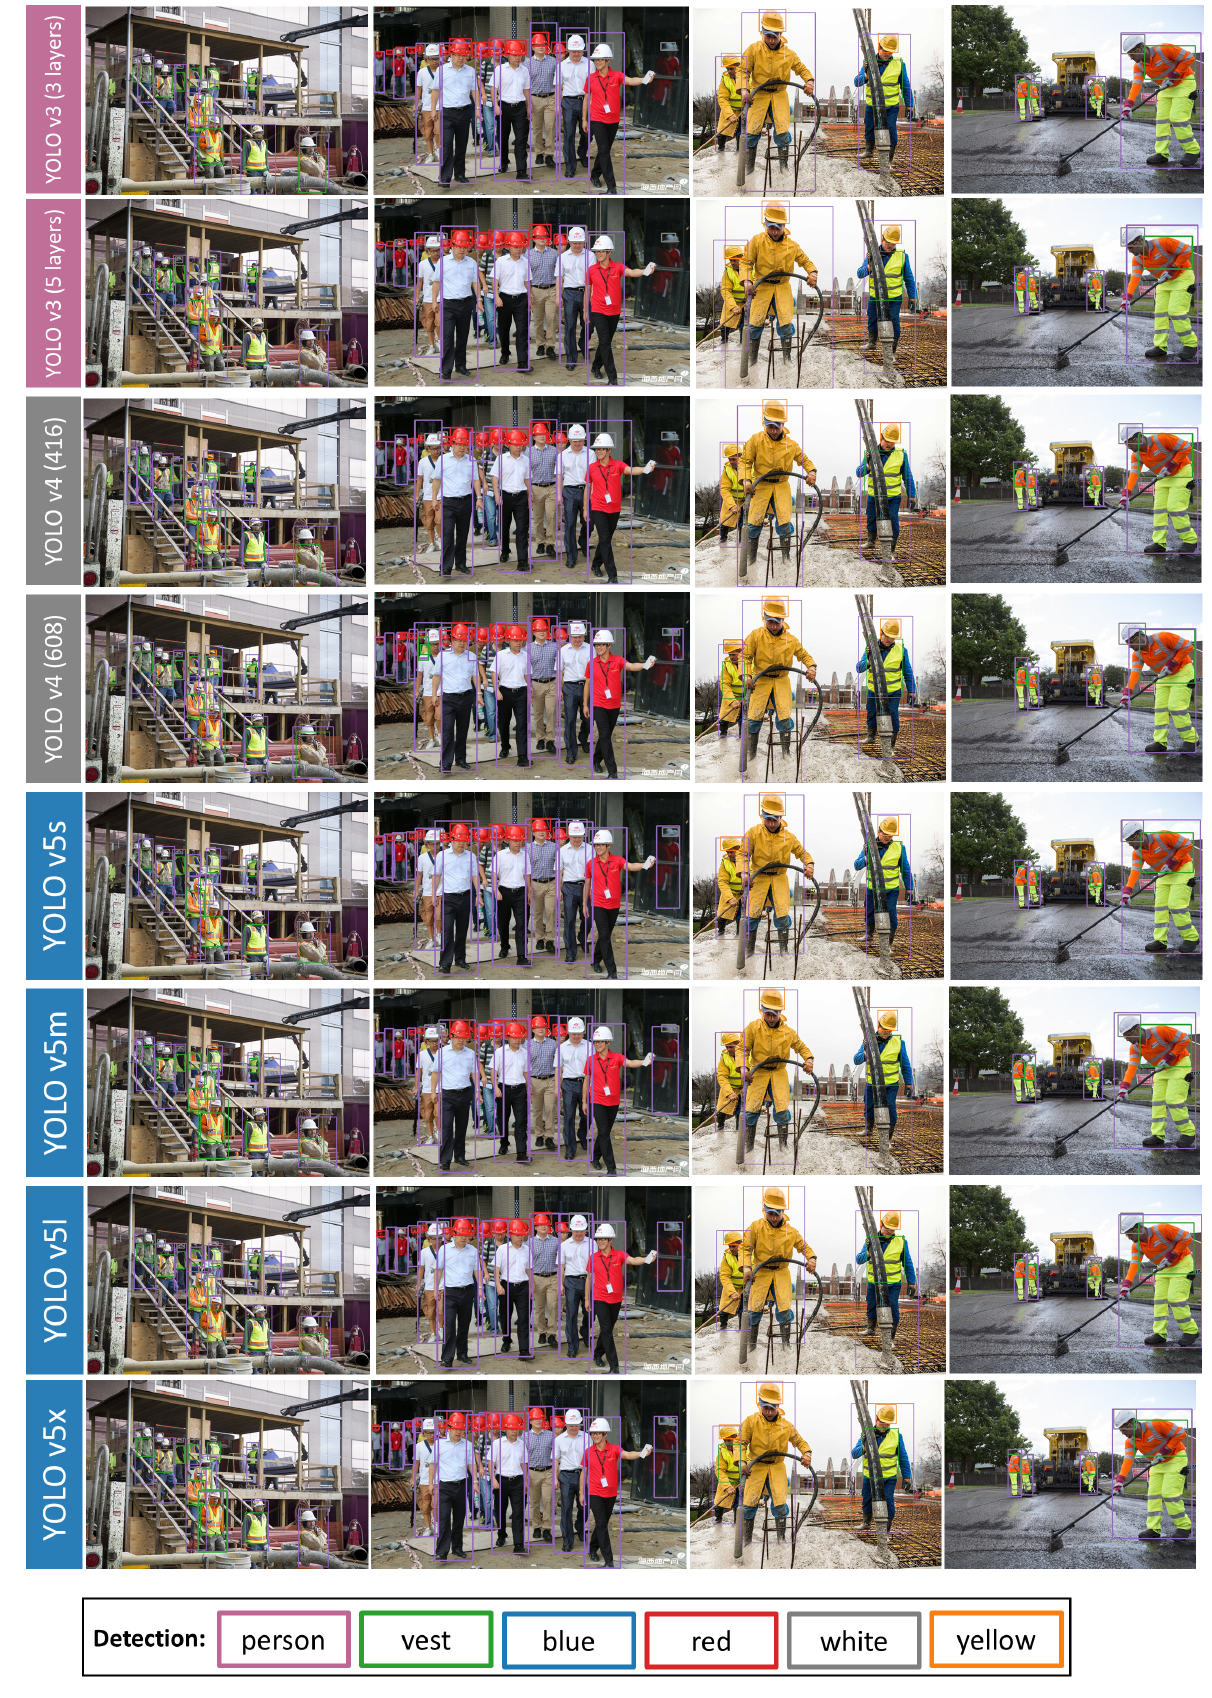
Figure 9. Examples of detection